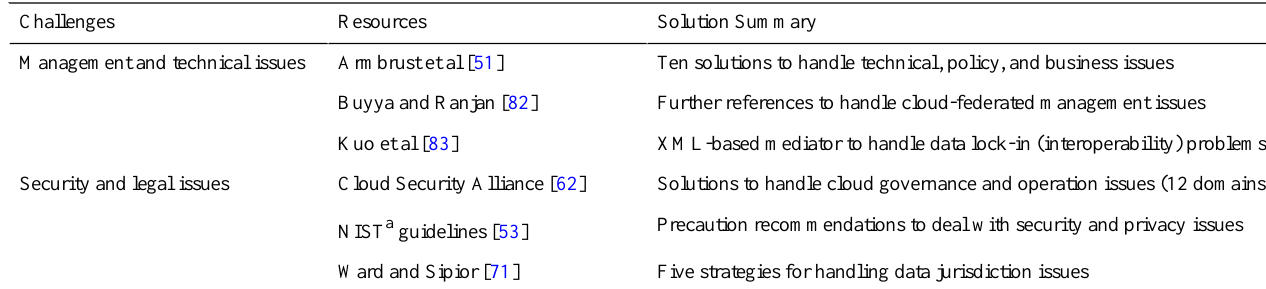
Table 2. Potential solutions to the cloud computing challenges